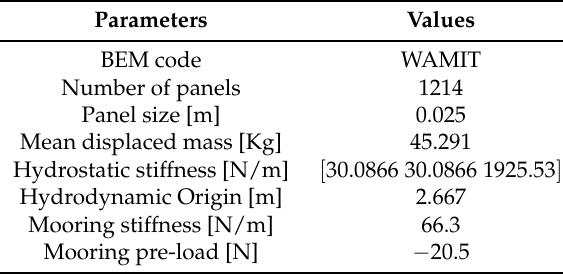
Table 5. Parameters of the X-MED model in WaveDyn.